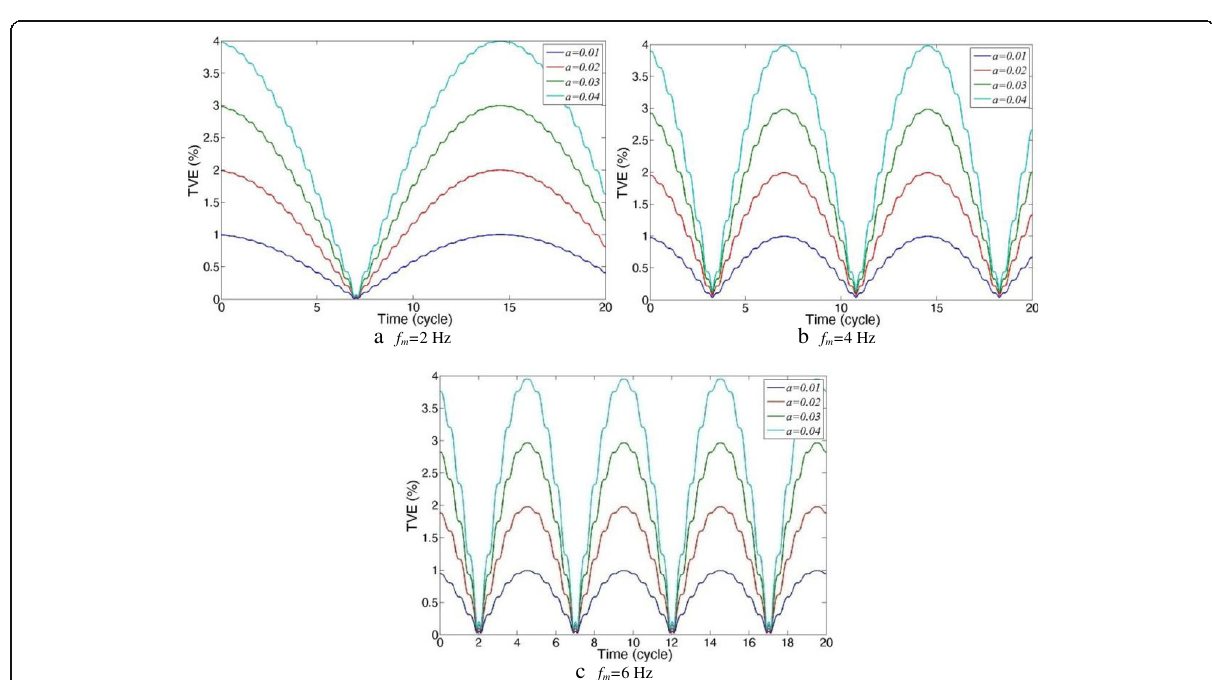
Fig. 13 TVE of phasor in phase modulation with different modulating factor and modulation frequency ( A = 1 p.u., f 0 = 60 Hz, φ 0 = 0)